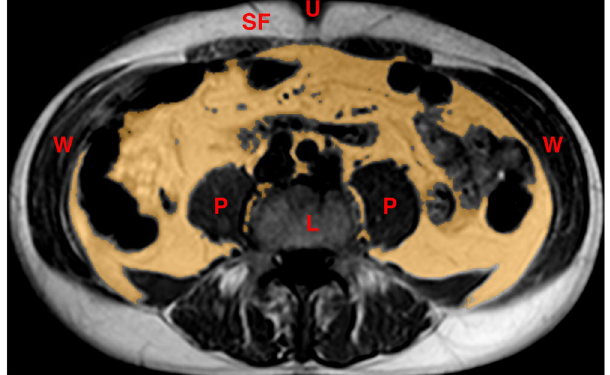
Figure 5. Abdominal fat area (masked in yellow) was measured from T 1 weighted transverse abdominal MRI at the level of umbilicus using segmentation technique. L = Lumbar vertebral body; P = Psoas muscle; SF = Subcutaneous fat; U = Umbilicus; W = Abdominal wall muscles.